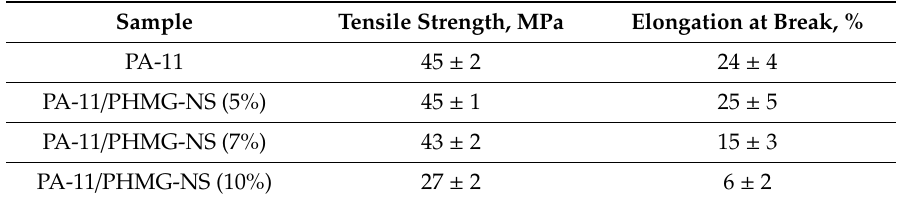
Table 2. Mechanical properties of PA-11 / PHMG-NS